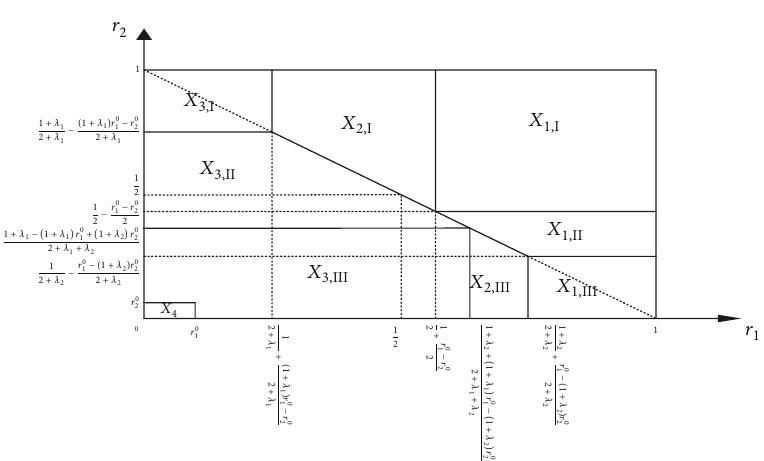
Figure 5: The equilibrium partitions for 𝛿 󳨀→ 1 , with 𝜆 2 > 𝜆 1 and 𝑟 0 1 > 𝑟 0 2